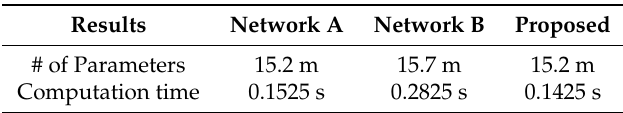
Table 4. The numbers of parameters of the networks and computation time of a single forward/backward routine per patch.